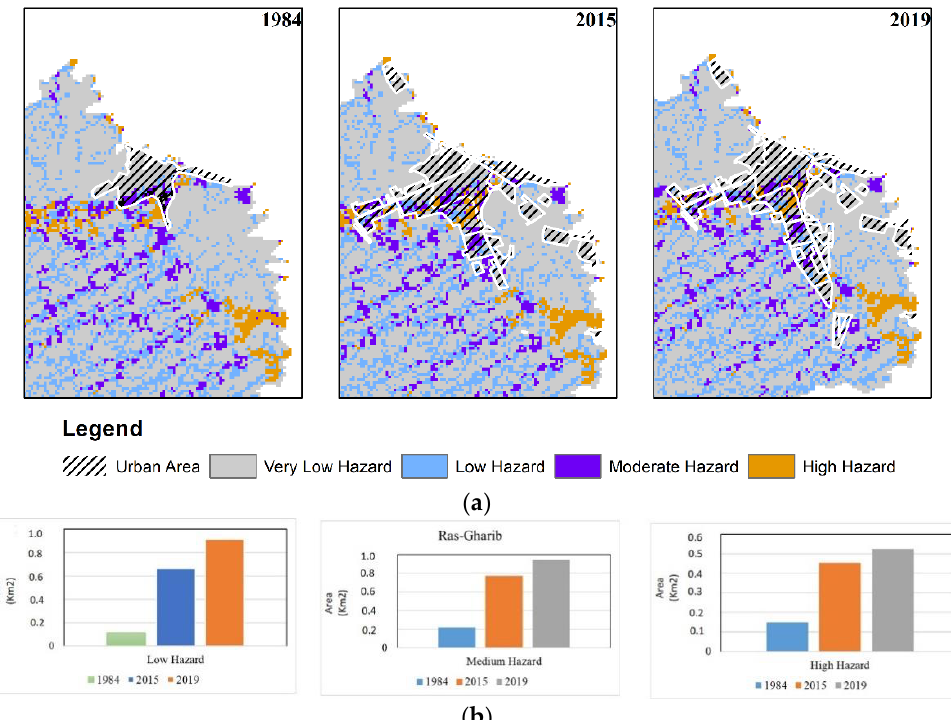
Figure 11. Inundation maps showing the hazard levels affecting the urban areas ( a ) and estimates of the vulnerable areas for flood hazard categories ( b ) over time from 1984 to 2019 in Ras Gharib.